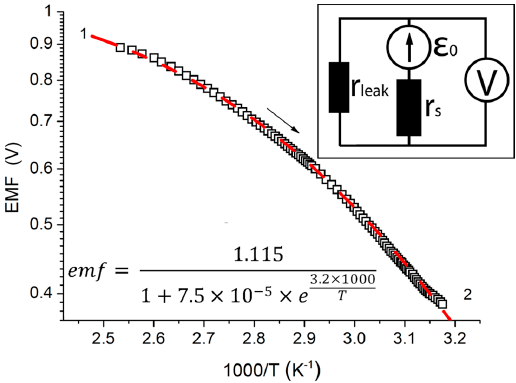
Figure 3. Dependence of emf generated by the structure on reciprocal temperature, semi-log plot, the dashed line shows an approximation of the dependence; (insert) - equivalent scheme of the model.